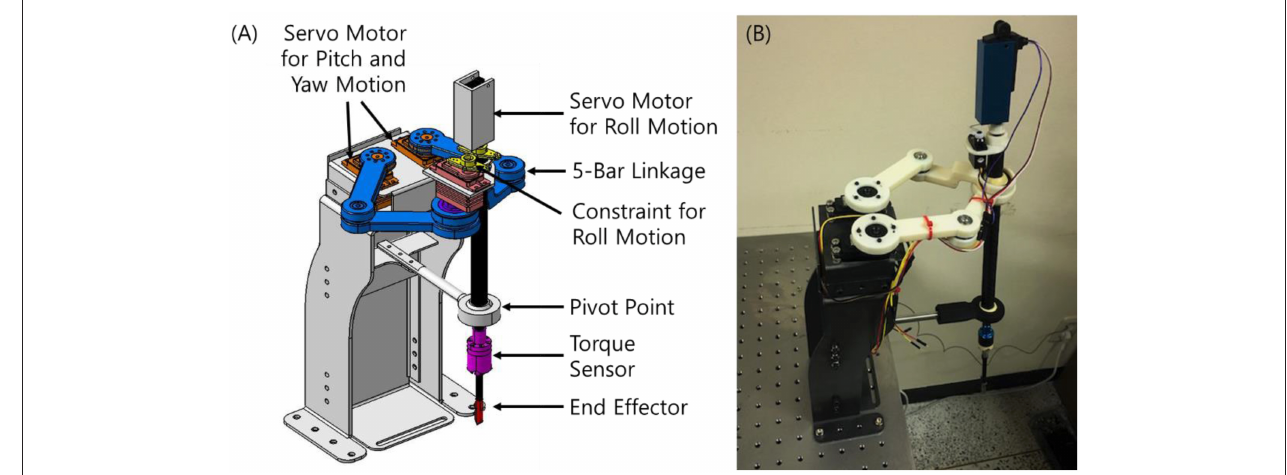
FIGURE 4 | The proposed slave robot. (A) Structural configuration. (B) Photograph.